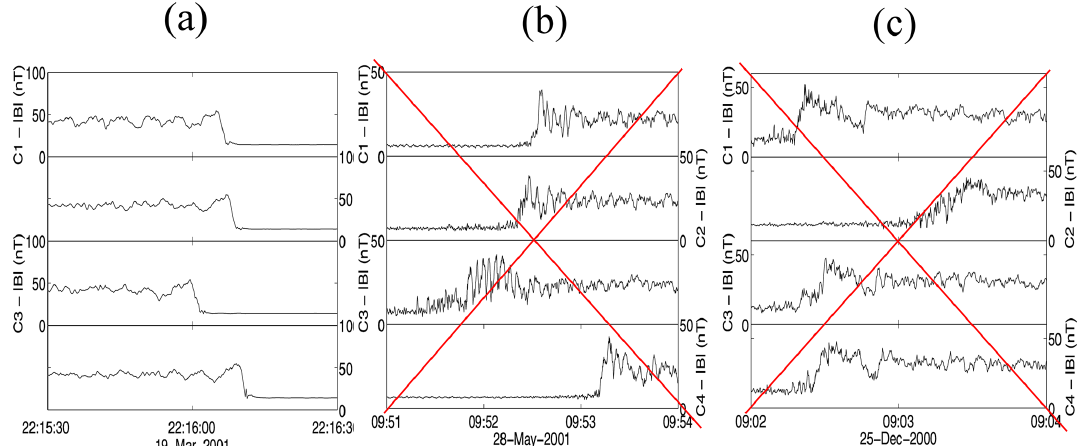
Figure 4. Three examples of the total magnetic field amplitude measured versus time by each of the four Cluster satellites during three different shock crossings at a resolution of five vectors per second. Panel (a) illustrates a good (selected) example of a clean and sharp shock, while panels (b) and (c) have been rejected in our selection since the shock either exhibits a complex and disturbed profile (b) or the shock certainly suffers an important acceleration (c) as shown between the profiles measured by the four spacecraft (inspired from Horbury et al., 2002).